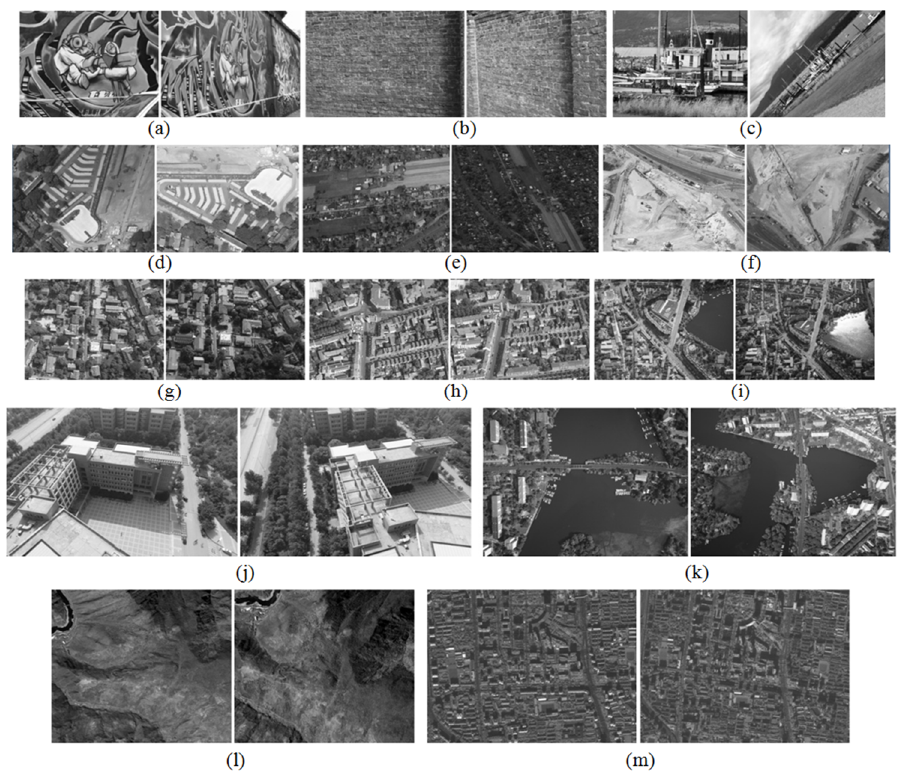
Figure 9. ( a – m ) Wide-baseline test data. These data are carefully selected from different platforms of ground close-range, UAV, and satellite, respectively. They cover various terrains and have significant viewpoint changes. Table 2. Description of the wide-baseline test data.